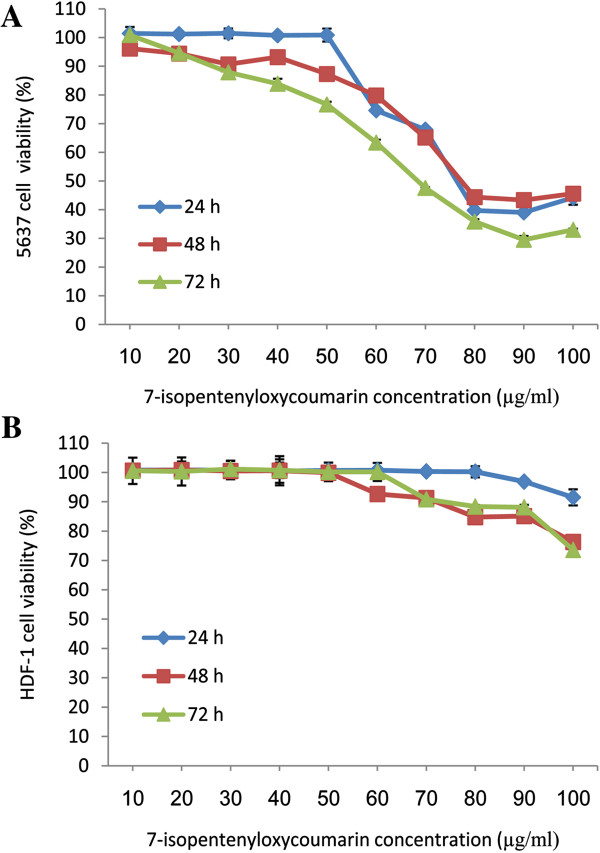
Time-based dose response curves of cancerous and normal cells. 5637 (A) and HDF-1 (B) cells treated with 7-IP during 24, 48 and 72 h. All the points represent results from three independent experiments performed in triplicate. Data are expressed as mean ± SD.